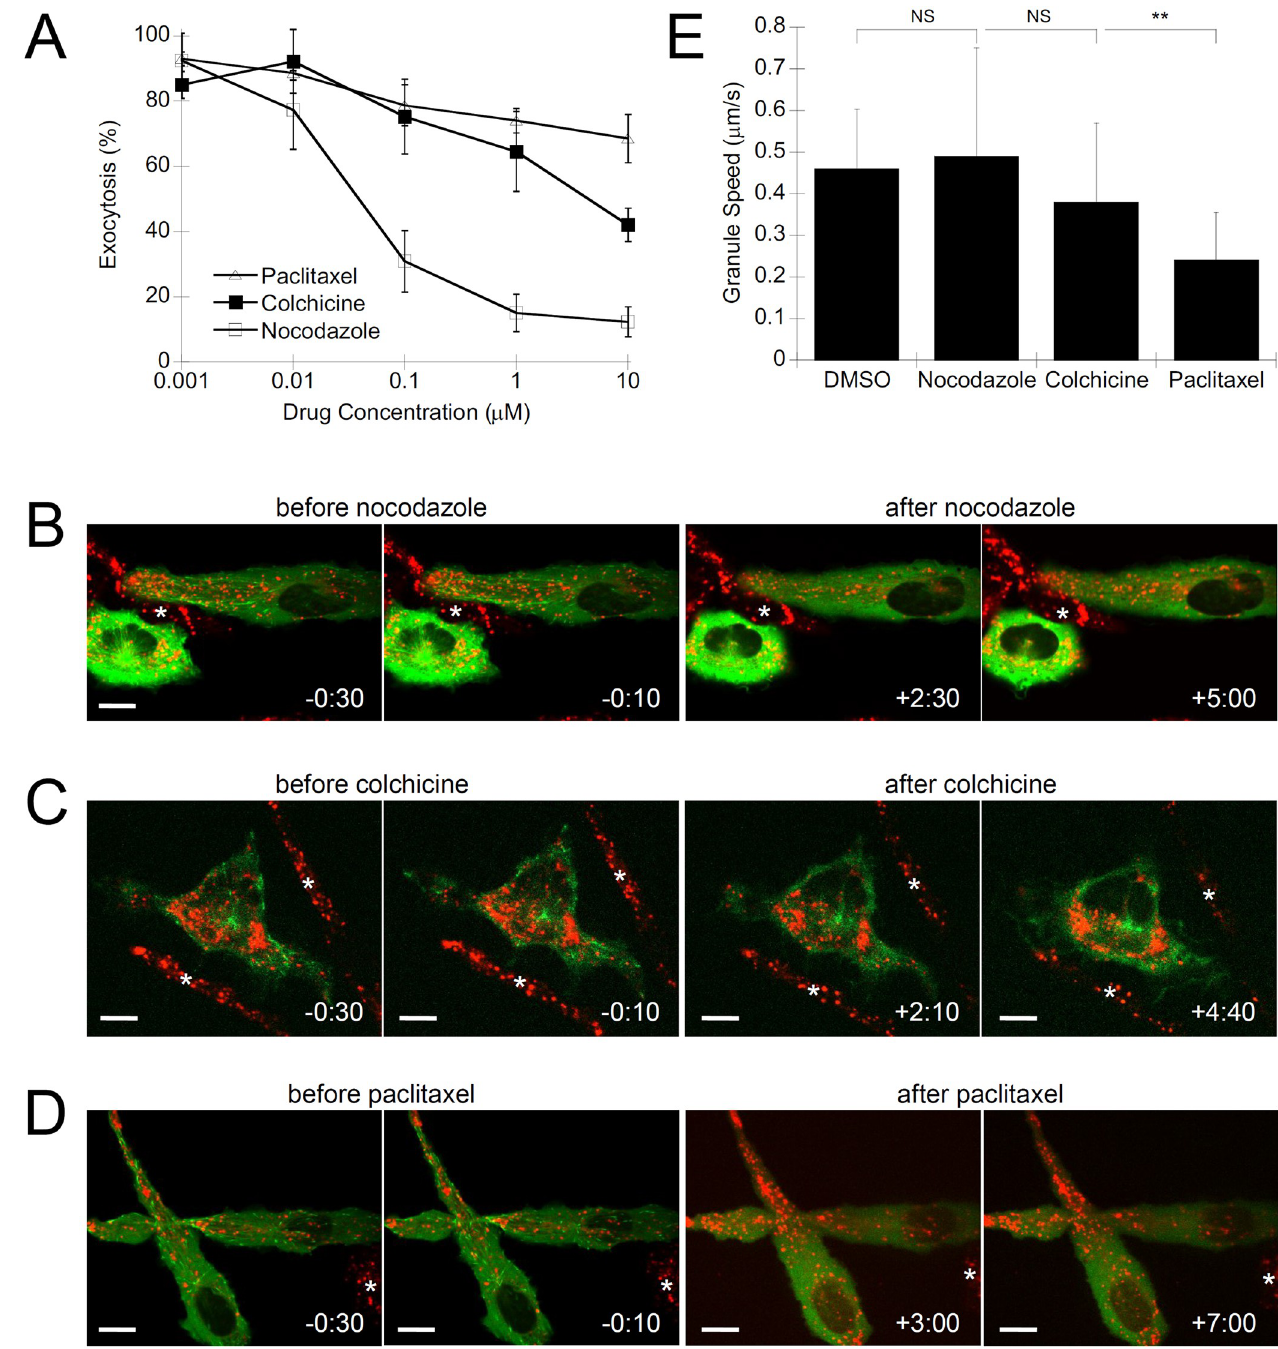
Fig 2. Microtubule drugs inhibit mast cell granule exocytosis and affect granule motility. A) Exocytosis assay of RBL-2H3 cells that were pre-treated with nocodazole, colchicine and paclitaxel for 30 min prior to antigen-stimulation. Exocytosis was assayed as the percent β -hexosaminidase released of total, normalized to vehicle (DMSO) controls (n = 3). B–D ) Representative confocal images from live-cell imaging of microtubule dynamics and granule movement of mast cells treated with 1 μ M nocodazole ( B , S3 Video via https://doi.org/10.6084/m9.figshare.19349558.v1), 10 μ M colchicine ( C , S4 Video via https://doi. org/10.6084/m9.figshare.19349564.v1), or 10 μ M paclitaxel ( D , S5 Video via https://doi.org/10.6084/m9.figshare.19349567.v1). RBL-2H3 cells were transfected with EB3-GFP to label nascent microtubules and incubated with LysoTracker red to label granules. Cells were imaged for 1 min, then antigen-stimulated and concurrently drugs were added, followed by 15 min of imaging. Scale bar, 10 μ m; � indicates untransfected cells. E) Granules at the cell periphery were analyzed by particle tracking software. A minimum of 15 granules from 5 cells were tracked. Shown is the mean granule speed +/- standard error. The effect of drugs was compared to the vehicle (0.5% DMSO) control by Student’s t -test (NS, not significant; �� , p = 0.0074; n =